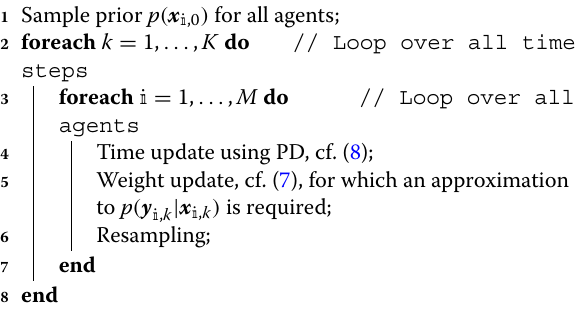
Algorithm 1: Outline of multiple particle